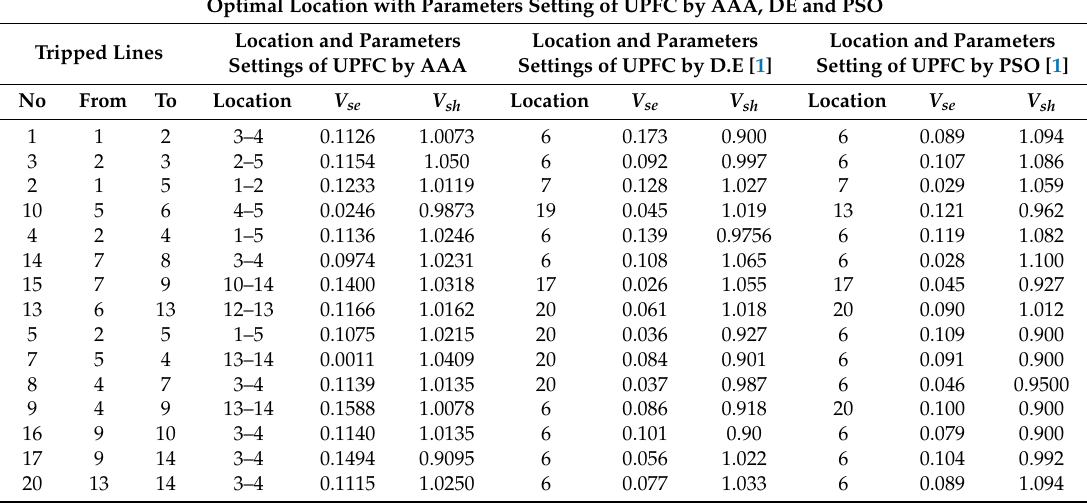
Table 6. Optimal location and parameters setting of UPFC by AAA, D.E and PSO (after 100 trials). Optimal Location with Parameters Setting of UPFC by AAA, DE and